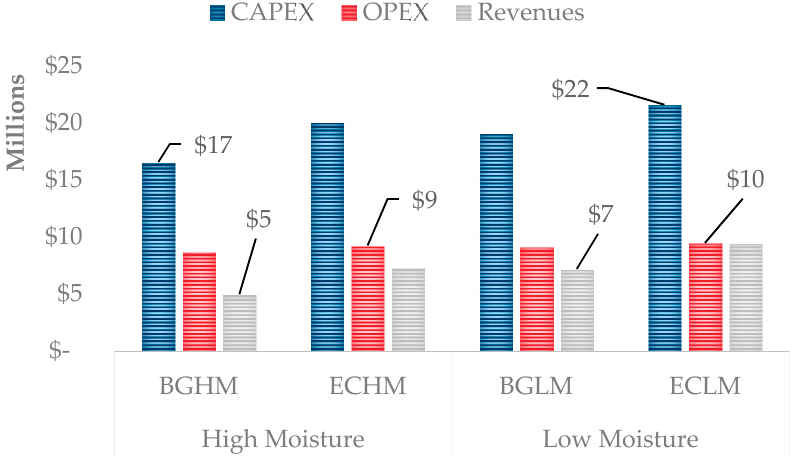
Figure 4. Economic indices including capital expenditure (CAPEX), operating expenditure (OPEX) and revenues generated from different scenarios (million USD). Table 3. The purchase cost of different equipment with their sizing data under different scenarios.